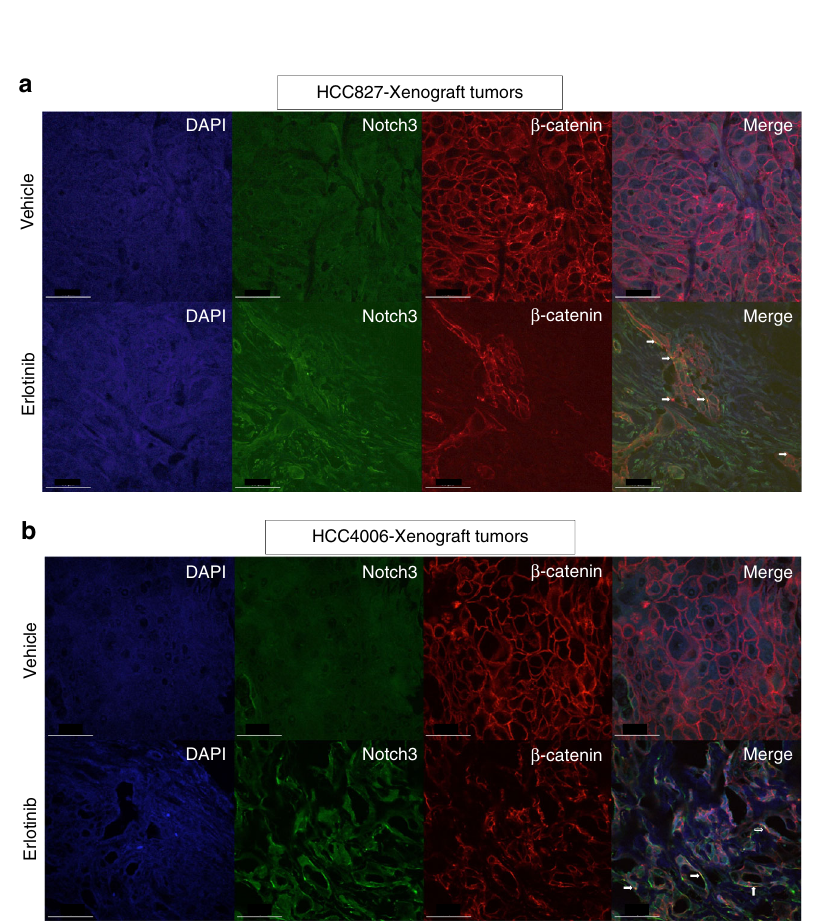
Fig. 7 In vivo demonstration of EGFR TKI therapy-induced co-localization of Notch3 and β -catenin. a , b EGFR TKI treatment increases co-localization of Notch3 and β -catenin in vivo. Co-localization experiment was performed as in Fig. 3c and d. For ( a ) and ( b ) scale bar is 50